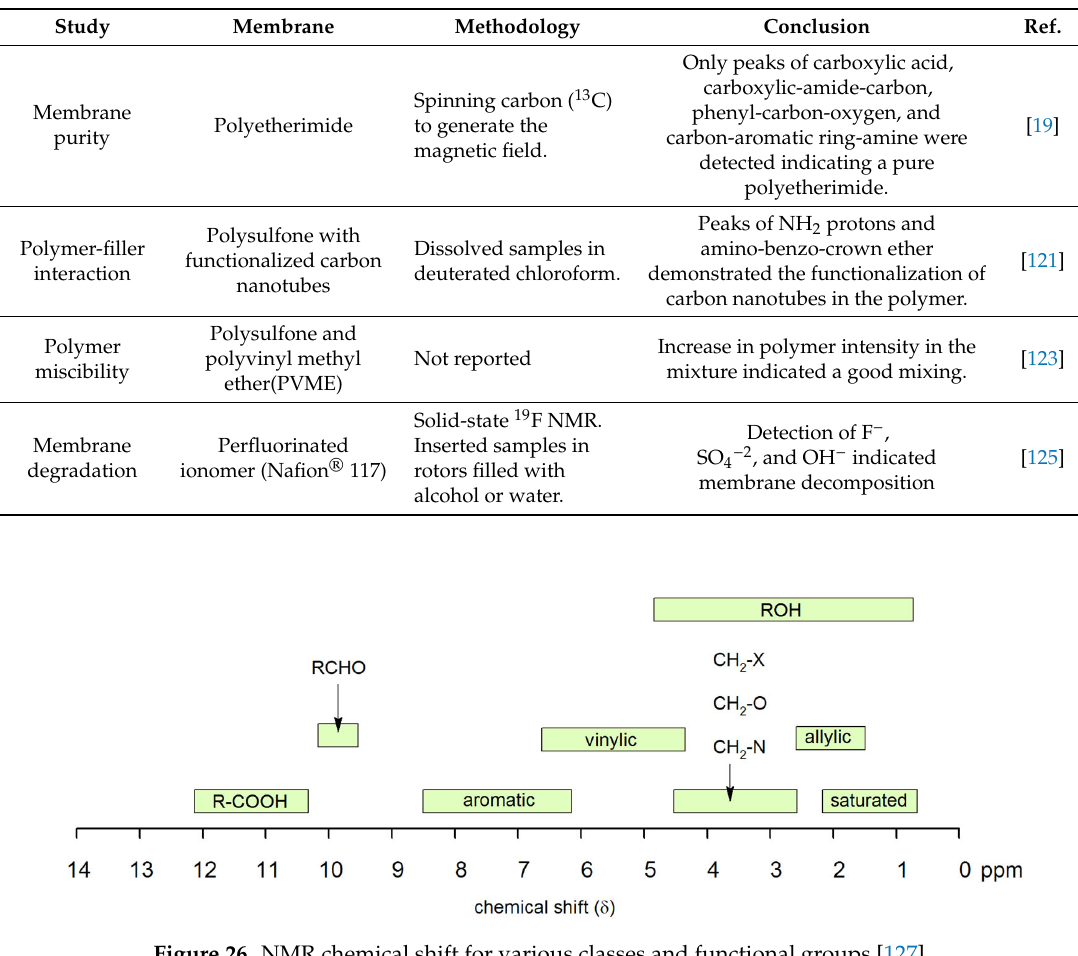
Figure 26. NMR chemical shift for various classes and functional groups [127].